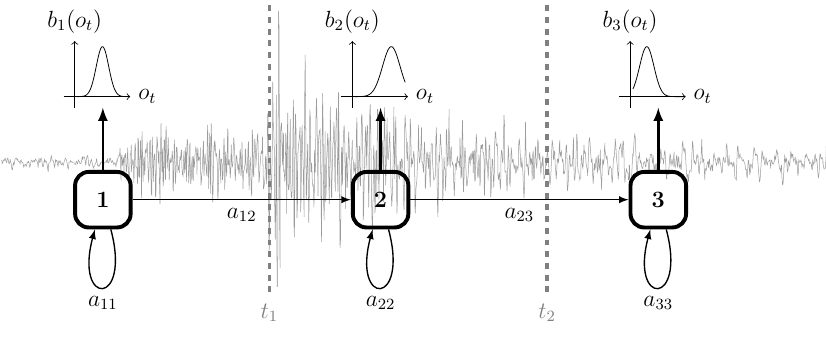
Fig. 2. Hidden Markov Model with three different states. The state transition probabilities are denoted with a ij . The observation distribution for each state is denoted with b i (o t ) .